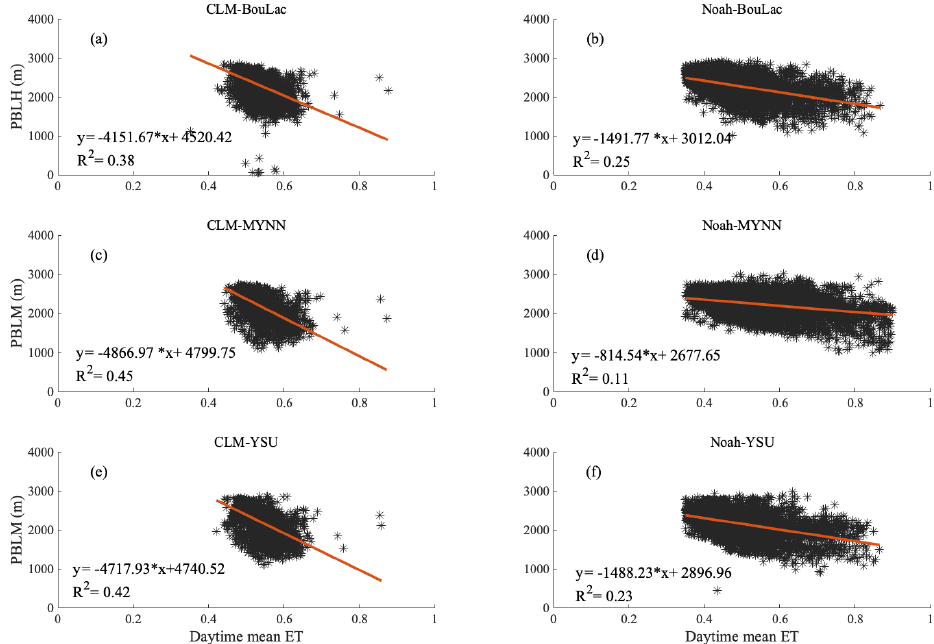
Figure 10. Relationship between mean daytime ET and the maximum daytime PBLH. Simulated by CLM and Noah with different PBL schemes. The grid in which the mean soil moisture is 1.0 is excluded to avoid the possible influence of lakes in the study area. The t test indicates that the fitting relationships of the four subplots pass 0.05 significance level